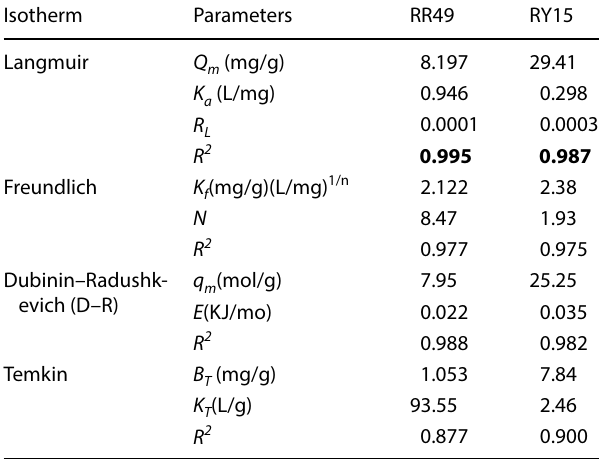
Table 3 The studied adsorption isotherms for RR49, and RY15 removal